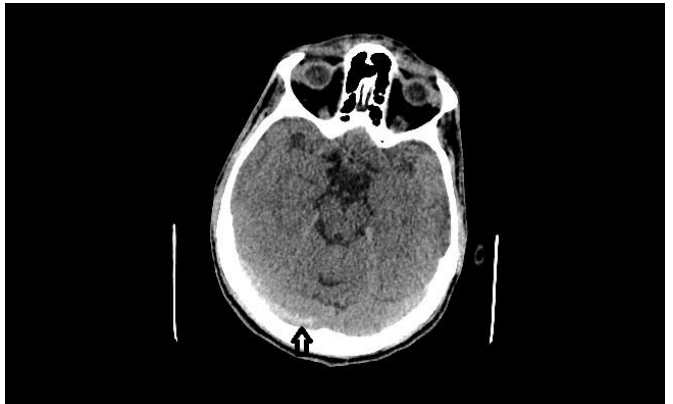
Figure 1. Computed tomography of the brain demonstrating hyperdensity in the region of right transverse sinus (arrow).